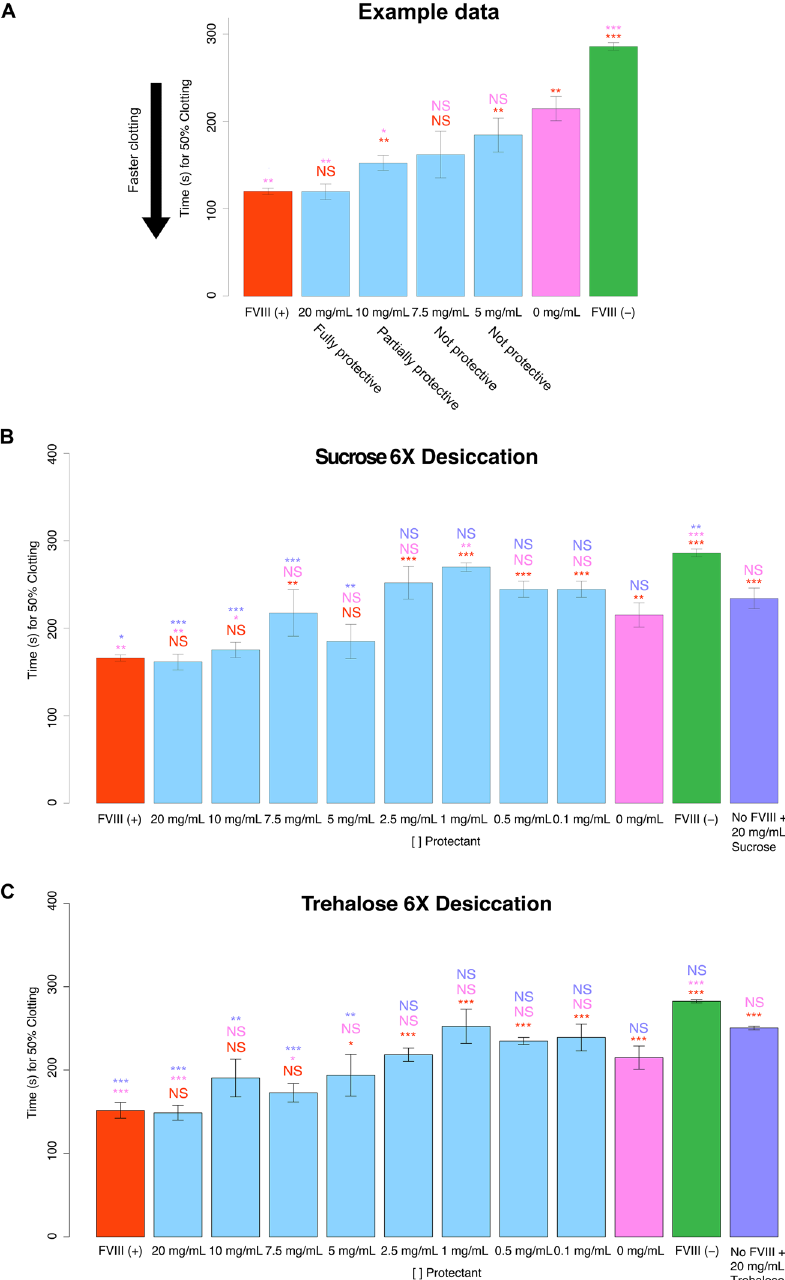
Figure 2. Non-reducing disaccharides stabilize FVIII under repeated desiccation cycles. ( A ) Example histogram. A protectant at a particular concentration (blue bars) is considered not protective if it is not statistically different from the 0 mg/mL control (pink bar). A particular protectant concentration is considered partially protective if its 50% clotting time is statistically lower than 0 mg/mL (pink bar), but also statistically higher than that of plasma supplemented with unperturbed FVIII (red bar). To be considered fully protective, a protectant concentration’s 50% clotting time must be statistically lower than 0 mg/mL (pink bar) and statistically indistinguishable from our positive control (red bar). Histogram showing the 50% clotting times for FVIII co-incubated with ( B ) sucrose or ( C ) trehalose. The red FVIII (+) bar represents FVIII deficient human blood plasma treated with FVIII that has not been desiccated. All red statistical notations above sample bars represent statistical comparison with FVIII (+). “X mg/mL” notations beneath sample bars correspond to the concentrations of non-reducing disaccharide mixed with FVIII before desiccation. All pink statistical notations above sample bars represent statistical comparison with “0 mg/mL of sugars.” The green FVIII (−) bar represents FVIII deficient human blood plasma with no supplemented FVIII. “No FVIII + X mg/mL Sugar” represents FVIII deficient human blood plasma treated with the indicated concentration of non-reducing disaccharide, but no FVIII. All purple notations above sample bars represent statistical comparison with “No FVIII + X mg/mL Sugar.” Notations above sample bars represent statistical significance determined by one-way ANOVA and Tukey’s post- hoc test. Error bars represent bi-directional standard deviation. P value > 0.05 = NS, P < 0.05 = *, P < 0.01 = **, P < 0.001 =